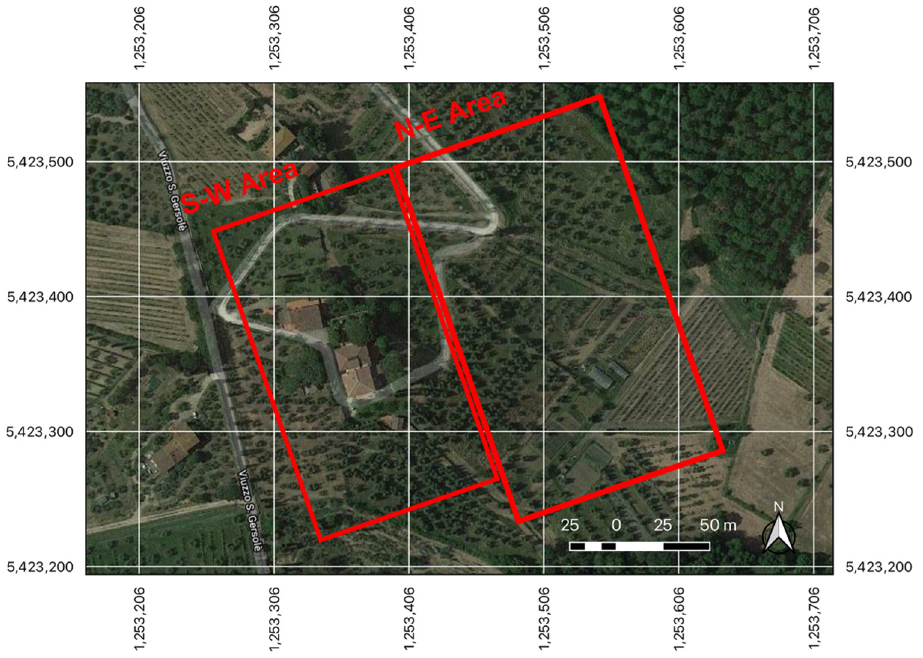
Figure 6. South-west and northeast testing areas. Table 2. UAS’ performed flight missions for different